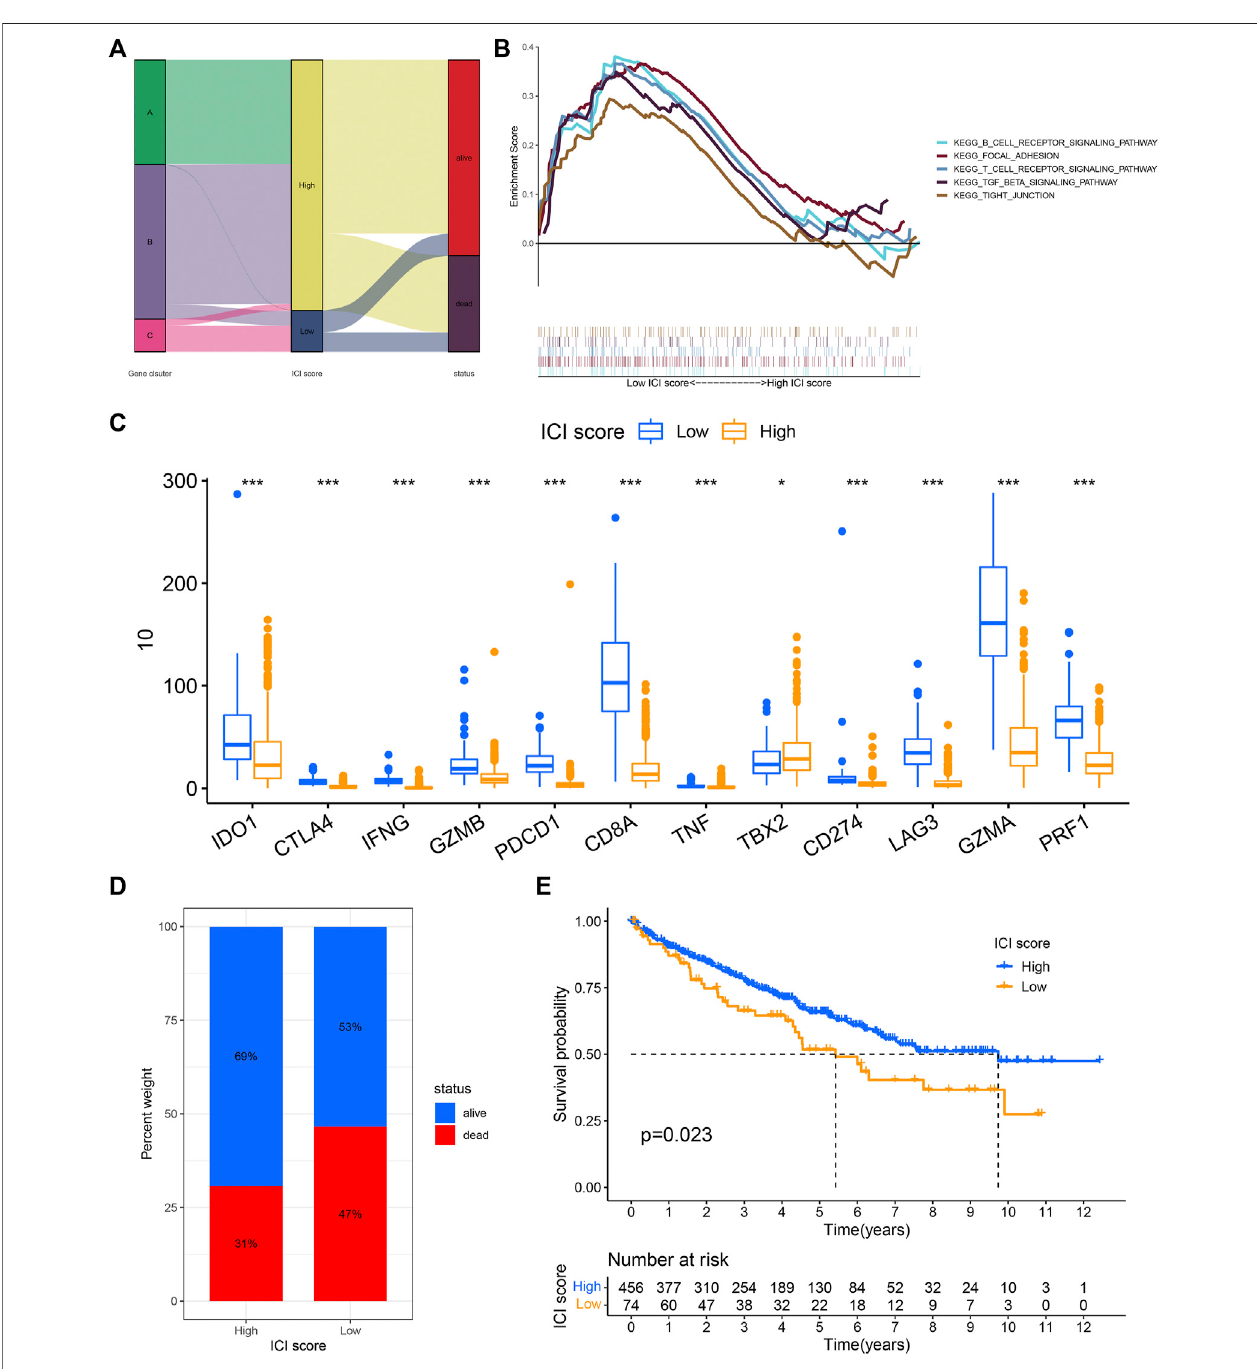
FIGURE 3 | ICI score was constructed. (A) Sankey diagram showed the relationship between gene cluster, ICI score, and survival status. (B) The gene set enrichment analysis (GSEA) in the low and high ICI score subgroups. (C) The difference in the expression of immune activity-related genes and immune checkpoint- related genes between low and high ICI score subgroups. (D,E) Kaplan-Meier curve analysis for low and high ICI score subgroups in the KIRC cohort (log-rank test p = 0.023).